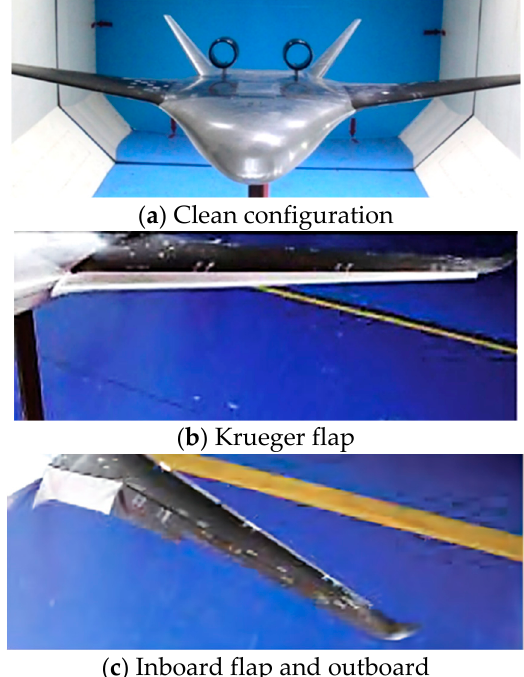
Figure 5. The experimental models of the BWB.